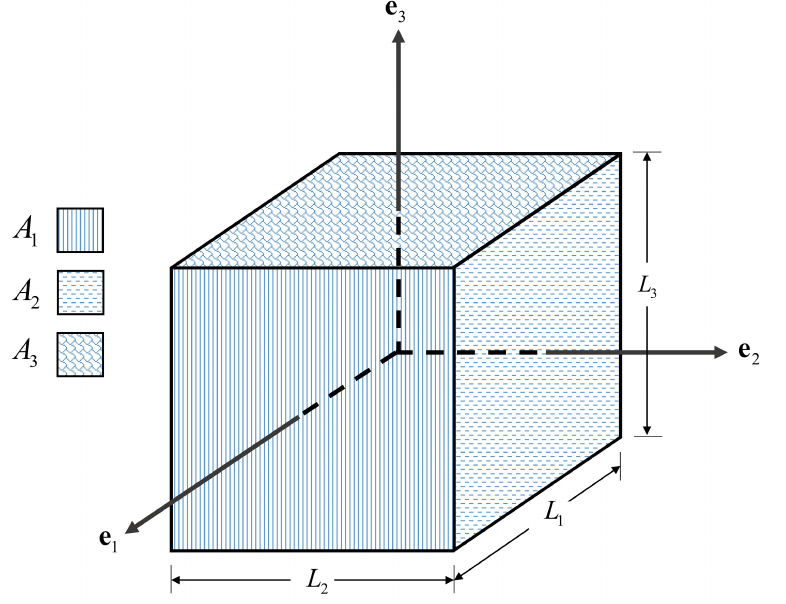
Figure 5. Cubic representative volume